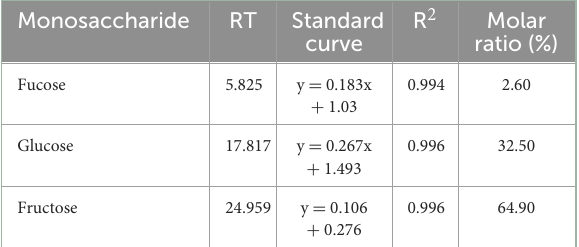
TABLE 2 Monosaccharide composition of